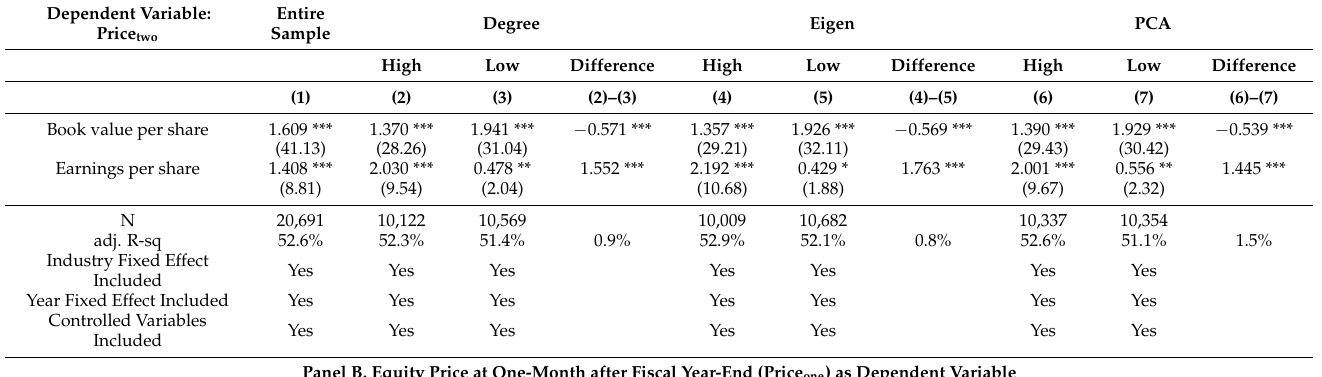
Panel B. Equity Price at One-Month after Fiscal Year-End (Price one ) as Dependent